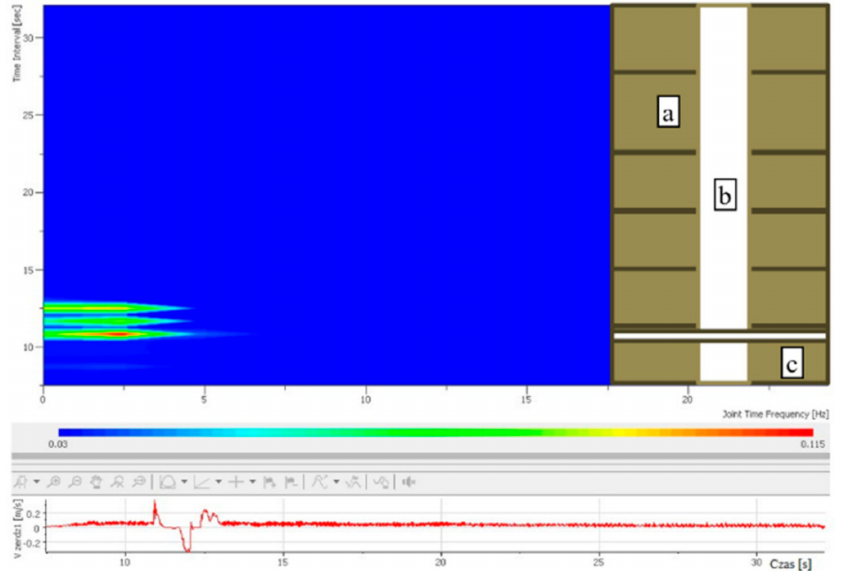
Figure 20. The detected signal on the recorded spectrogram corresponding to the location the critical discontinuity for borehole 9, rod 1—Hanning window, time domain grid line set to 50, amplitude level display > 0.03; a, rock layer; b, borehole; c, discontinuity.